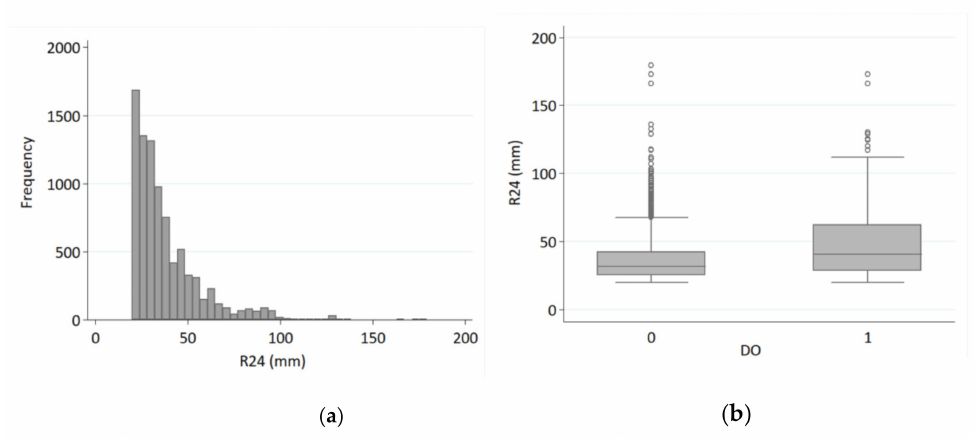
Figure 2. ( a ) Frequency distribution (histogram) of R24, at the PC spatial analysis. ( b ) Distribution (boxplot) of R24 over the binary damage occurrence variable, DO.